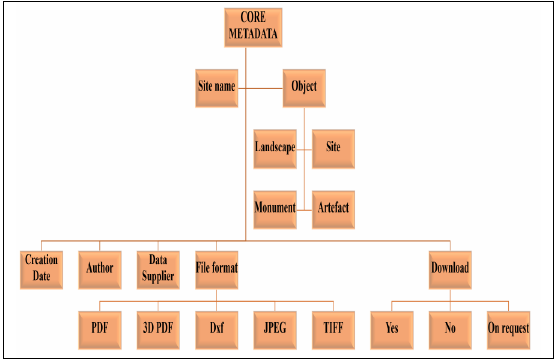
Figure 9. Core metadata